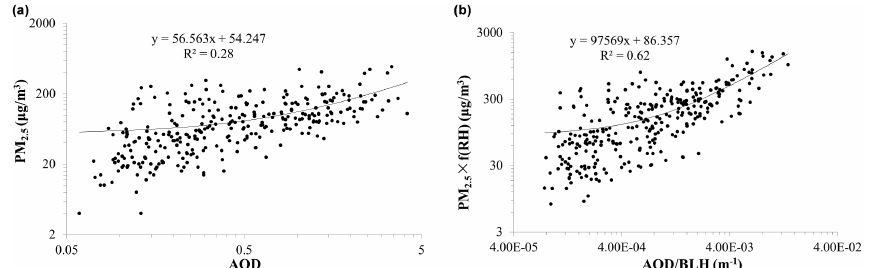
Figure 3. Relationship between daily AERONET AOD and PM 2 . 5 from 10 May 2010 to 6 December 2011 in Beijing: (a) without BLH and RH correction (b) with BLH and RH correction.